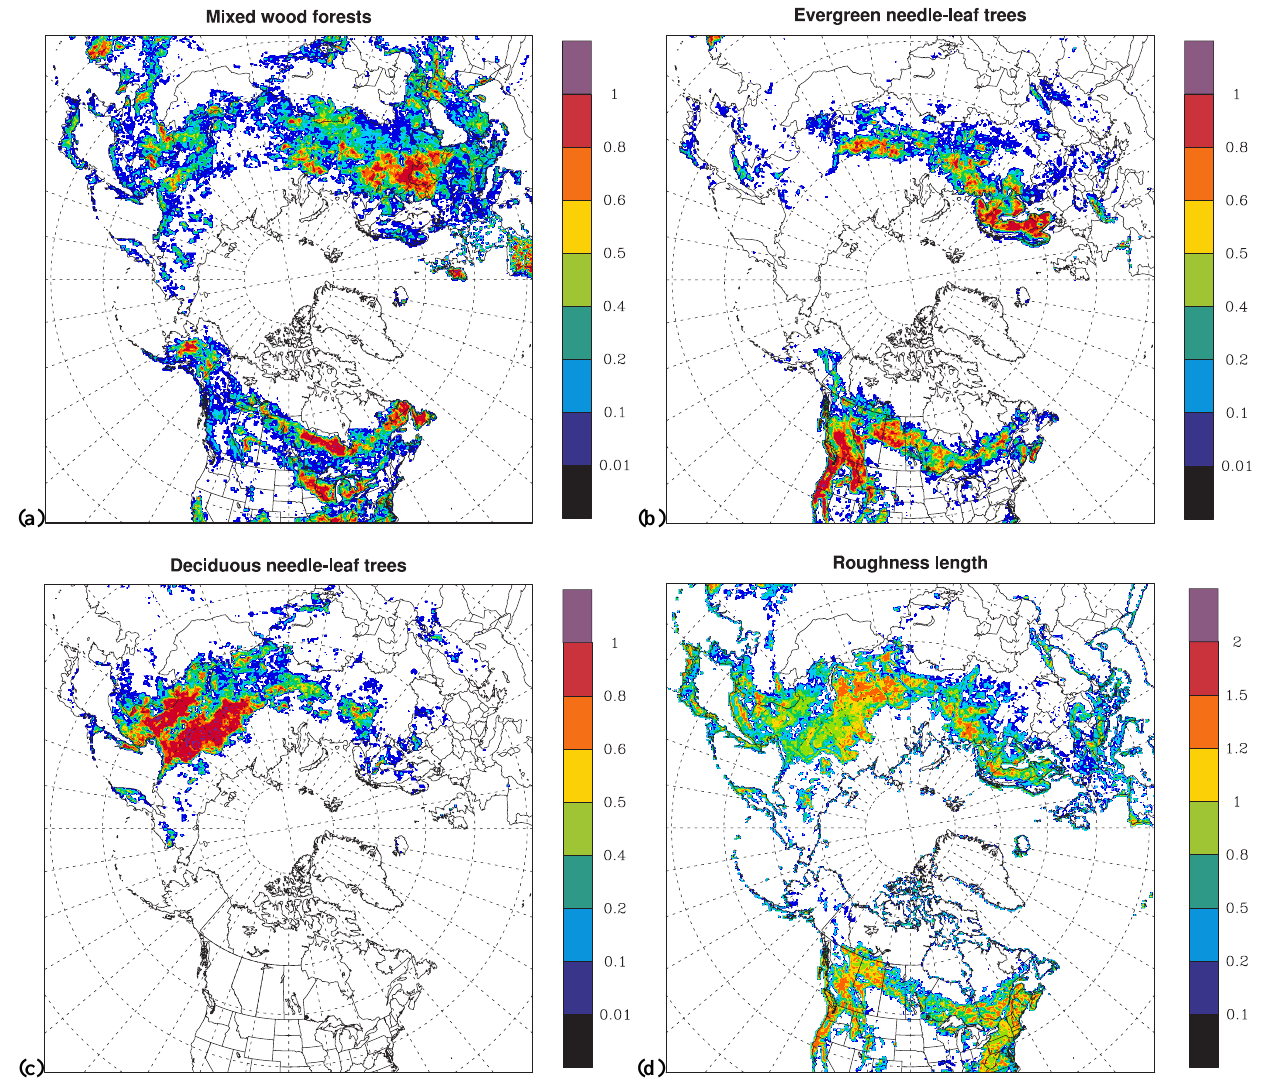
Fig. 9. Spatial distributions of different vegetation types: (a) mixed wood forests, (b) evergreen needle-leaf trees, (c) deciduous needle-leaf trees (units in fraction), and (d) roughness length (units in